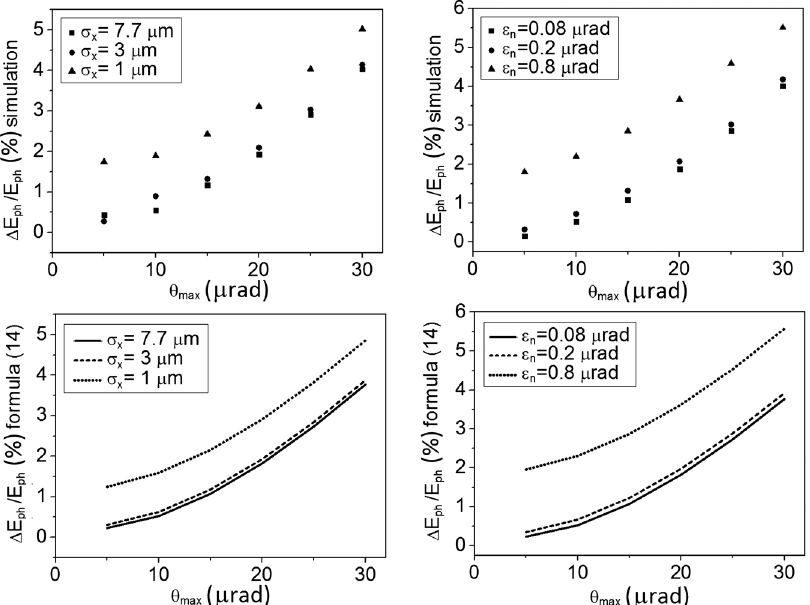
=E (%) as a function of θ ph ph